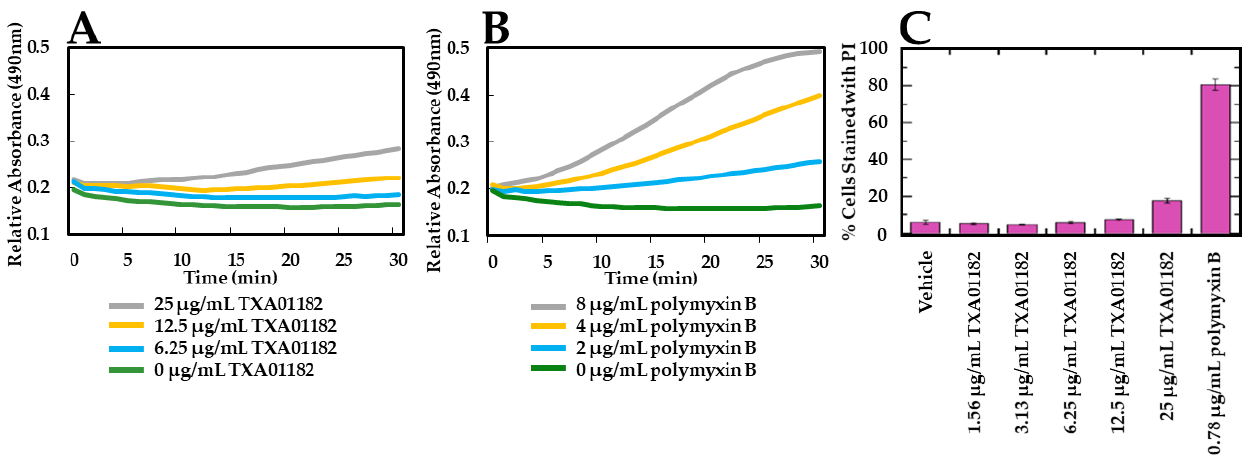
Figure 4. Outer- and inner-membrane permeabilization studies with TXA01182. Basal levels of NCF hydrolysis ( A , B ) or PI fluorescence ( C ) are observed upon addition of TXA01182 at concentrations below 12.5 and 25 μg/mL, respectively, indicating intact outer and inner membranes.